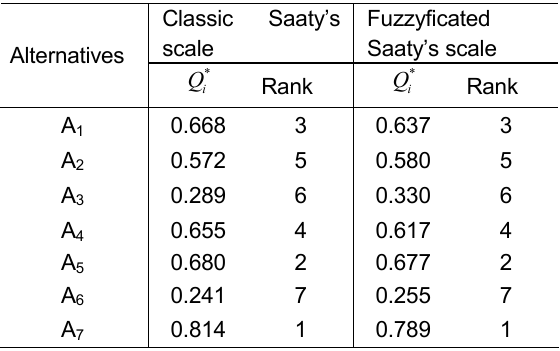
Table 7 – Comparative summary of the solutions with the change of the initial elements Таблица 7 – Сравнительный обзор решений с изменением исходных